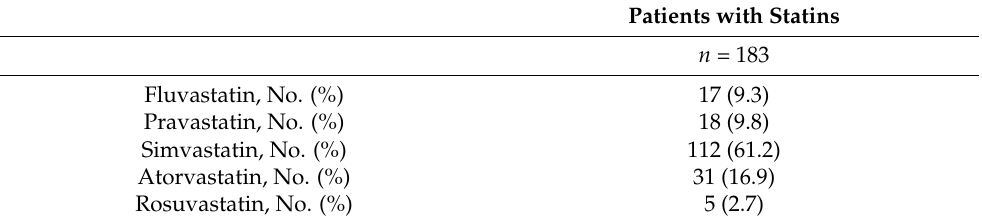
Table 2. Type of statin prescribed in this study.